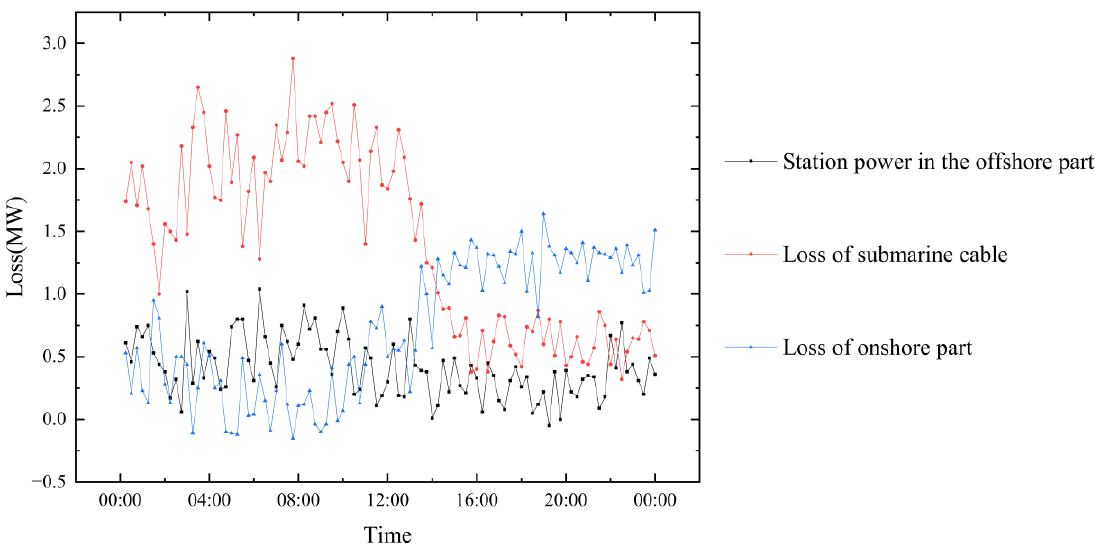
Figure 8. The loss of the wind farm.